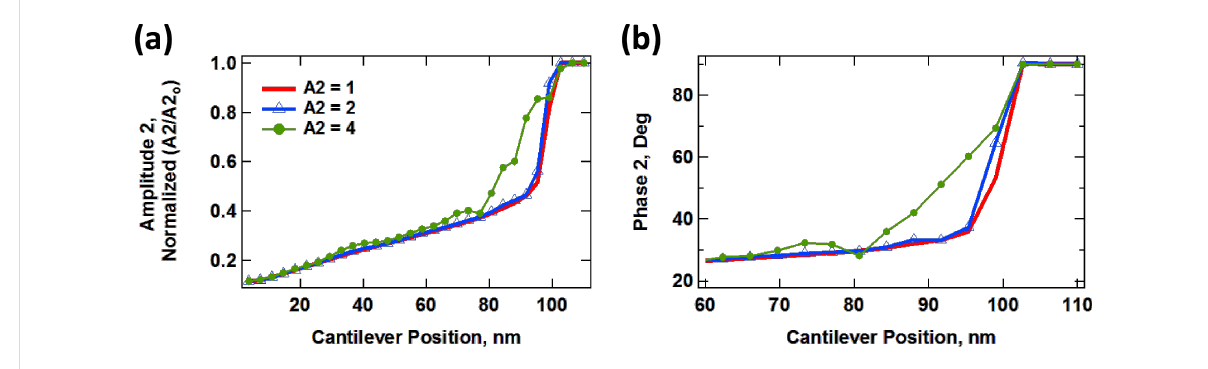
Figure 9: Simulated amplitude and phase spectroscopy curves for realistic cantilever trajectories calculated using parameters similar to those of Figure 7 for AM-OL operation. (a) Normalized amplitude ( A 2 / A 2-free ) vs cantilever position; (b) phase vs cantilever position.